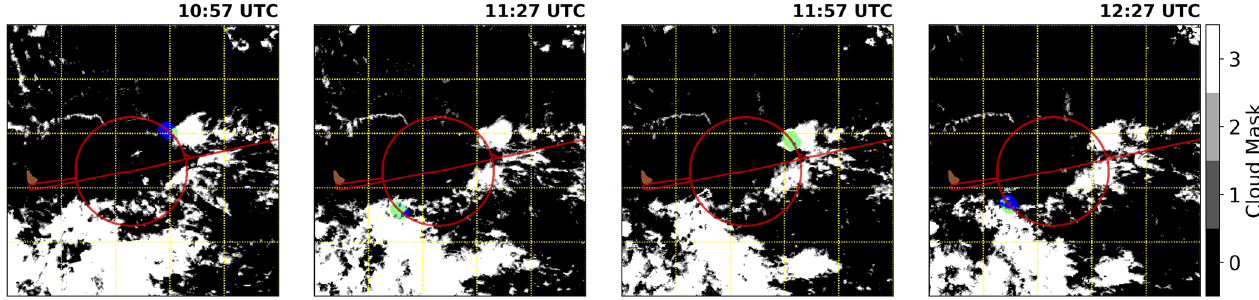
Figure 1. Four example scenes from the flight on 24 January 2020. The cloud mask product from GOES is displayed, with the blue (cloud- free) and green (cloud) colors indicating the collocated 102 ◦ footprint of BACARDI. The solid red line indicates the flight track. The island of Barbados is shown in brown for